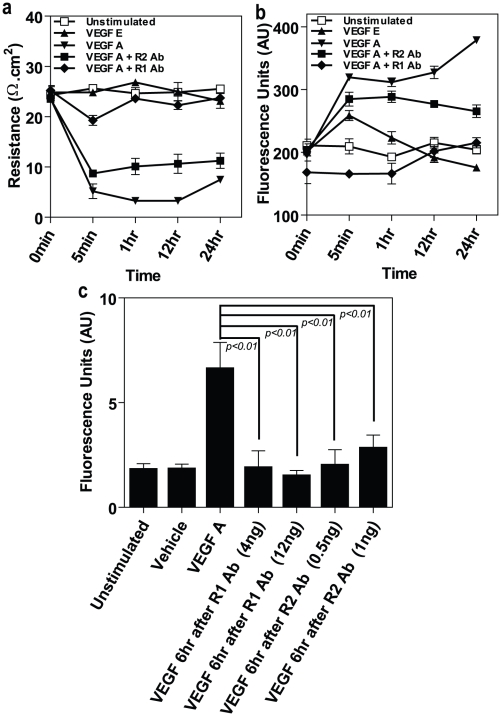
VEGFR-1 is a critical regulator of VEGF-induced permeability.(a) Temporal changes in transendothelial resistance across a microvascular endothelial monolayer grown on a transwell insert treated with VEGFA alone (100 ng/ml), VEGFE alone (100 ng/ml), and VEGFA (100 ng/ml) + a neutralizing antibody (2 µg/ml) to VEGFR-1 or VEGFR-2 (n = 4 independent experiments). (b) Paracellular macromolecular permeability to 40 kDa Dextran-FITC using the conditions described in (a) (n = 4 independent experiments). (c) The effect of neutralizing antibodies to VEGFR-1 (4 or 12 ng/eye) and VEGFR-2 (0.5 or 1.0 ng/eye) on VEGF-induced permeability in C57BL/6 mice. Neutralizing antibodies were given by intravitreal injection and VEGF (60 ng/eye) was injected 6 hours later. 46 hours post the first injection mice received tail vein injections of FITC-labeled albumin and retinas were taken for analysis 2 hours later (n = 6 per group). Data are represented as means ± s.e.m. *p<0.05, ** by p<0.01 (Student's t test and ANOVA for multiple comparisons).